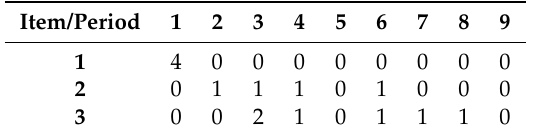
Table 3. Optimal purchase orders during the shifted planning